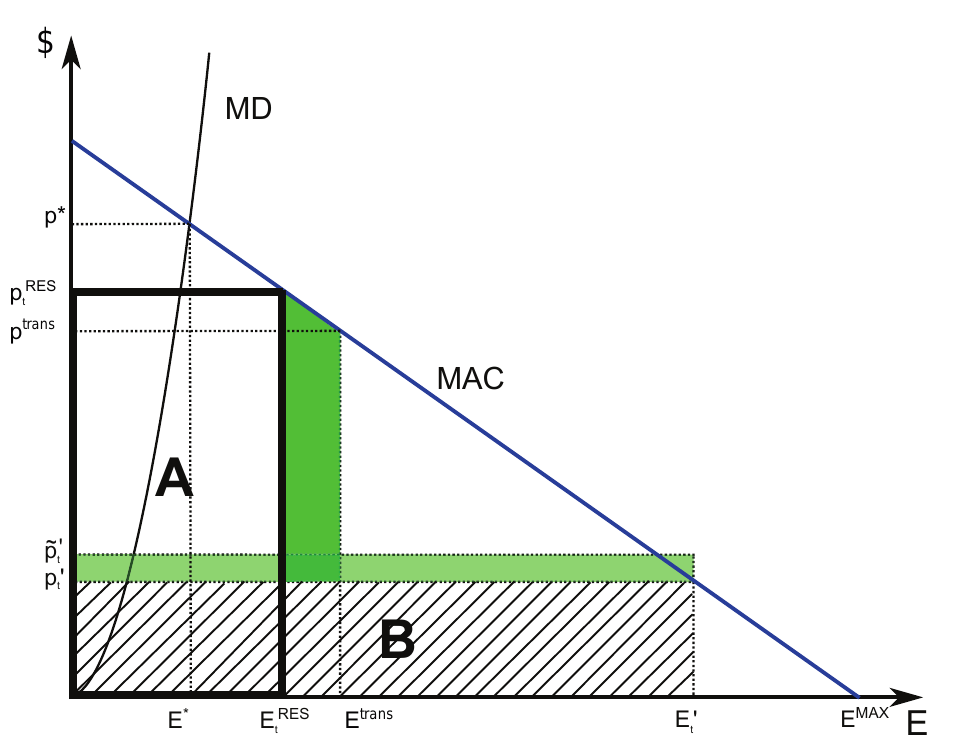
Figure 1. CO 2 emissions with respective marginal abatement costs (MAC) and marginal damage (MD). The figure depicts prevailing emission levels for different scenarios on the abscissa and associated price levels on the ordinate axis. The long-run emission objective is indicated by the optimal emission level E ∗ and corresponding price p ∗